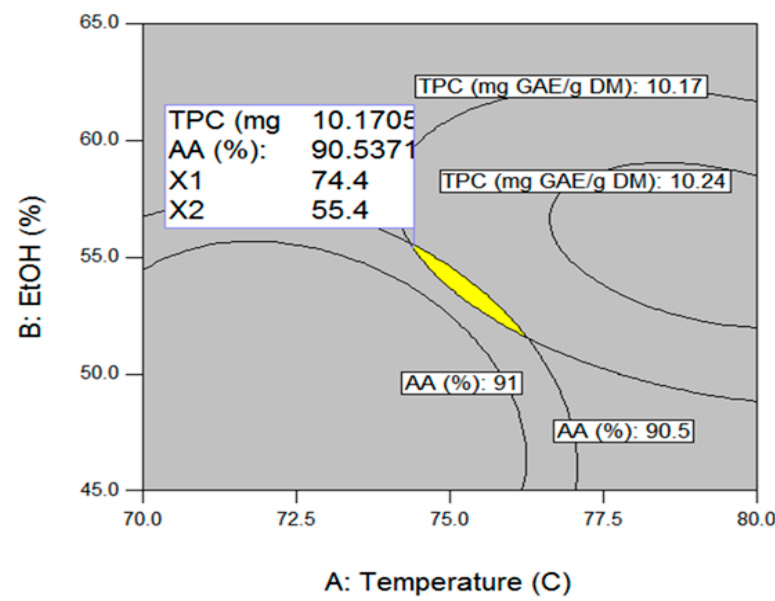
Figure 8. Optimization of extraction of total phenolic compounds and antioxidant activity based on the superimposing method. The interactive effect of extraction time and ultrasonic power on total phenolic compounds ( a ) and antioxidant activity ( b ) at constant levels of extraction time of 59.6 min, and ultrasonic power of 700 W.